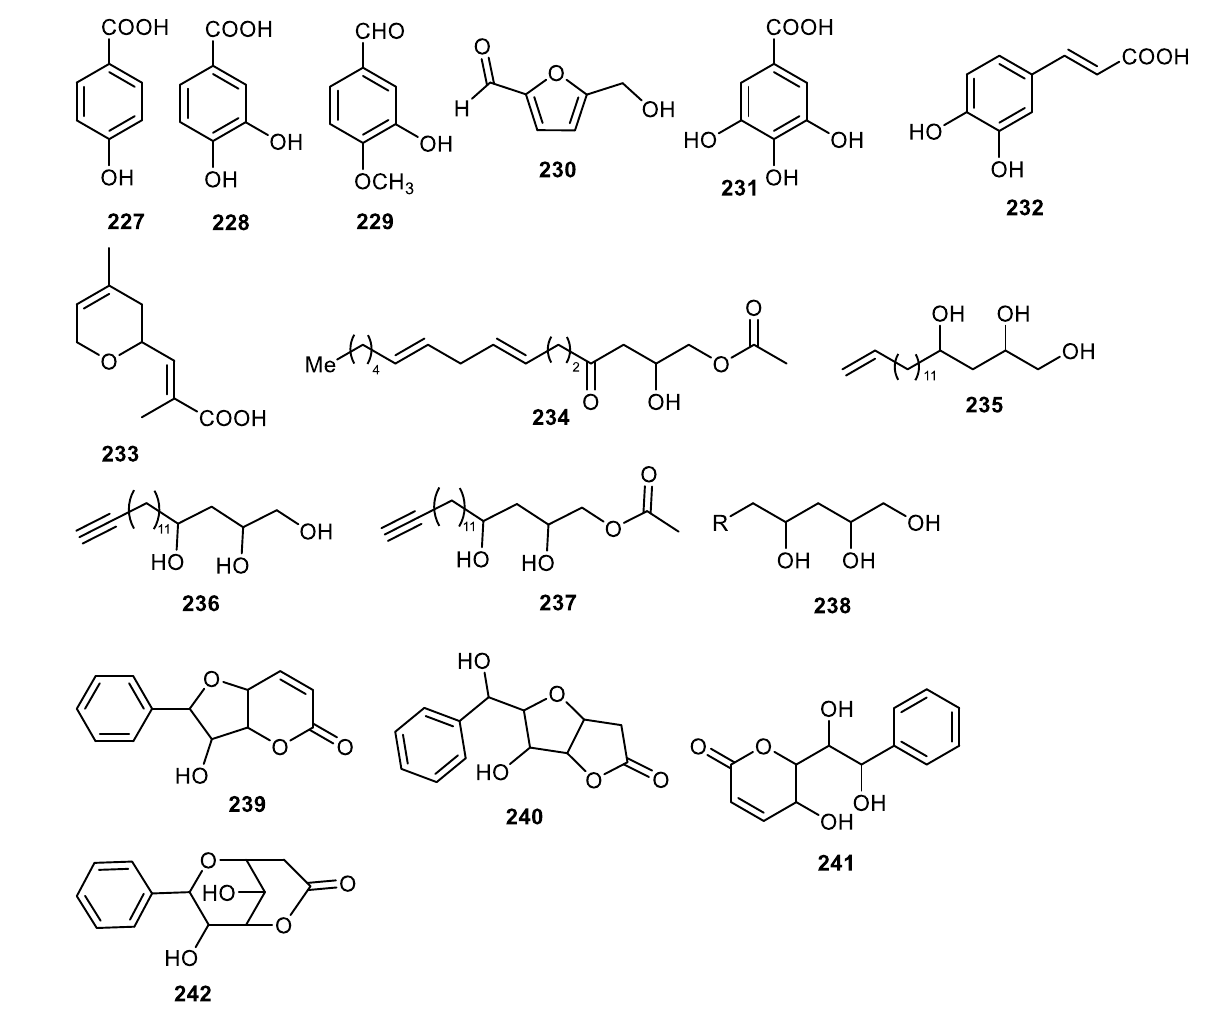
Figure 28. Structures of compounds 227 – 242 .